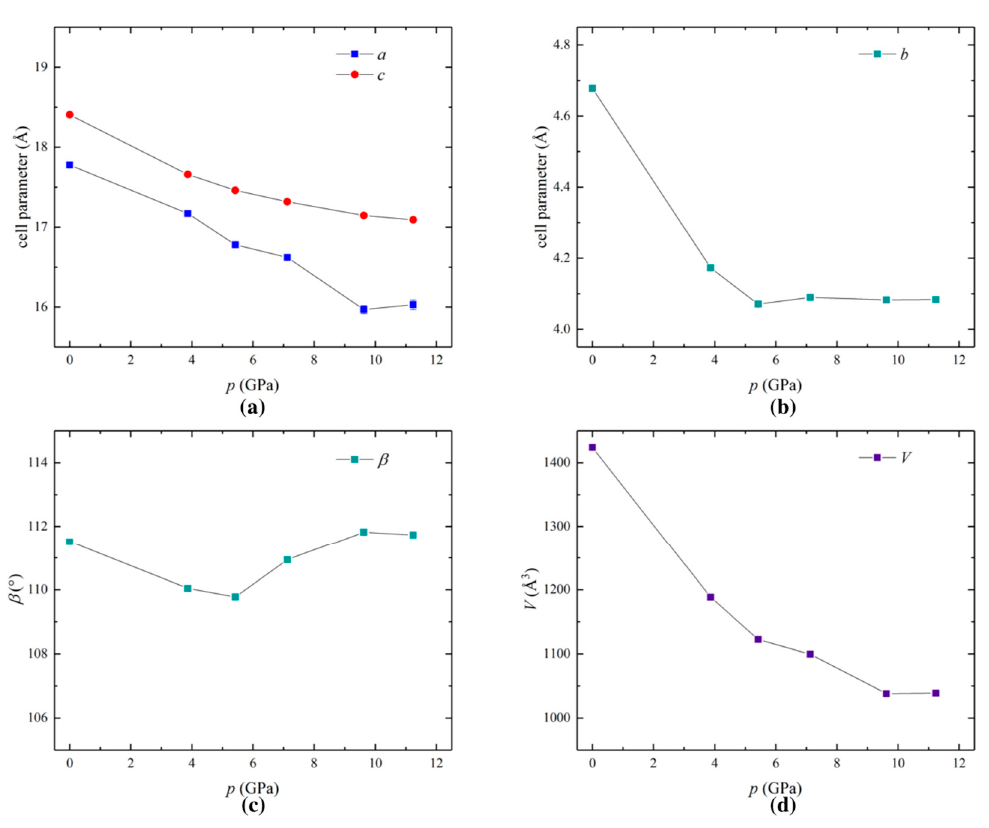
Figure 3. Changes in the crystallographic unit cell parameters of [Ni(dddt) 2 ], showing variations in ( a ) the a and c axes, ( b ) the b axis, ( c ) the monoclinic angle, β , and ( d ) the unit cell volume, V .